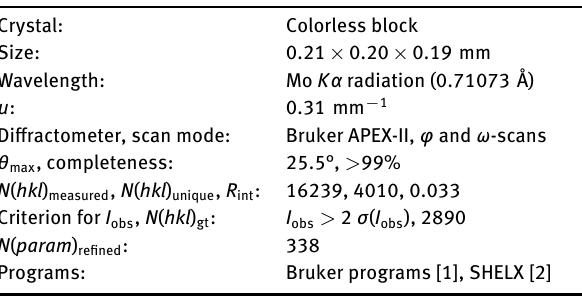
Table 1: Data collection and